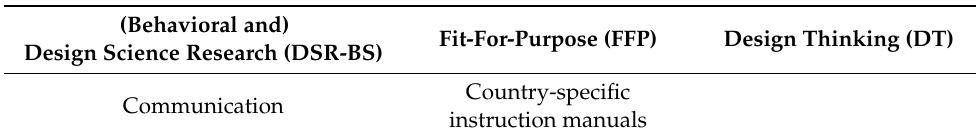
Table 10. Extract of the communication process